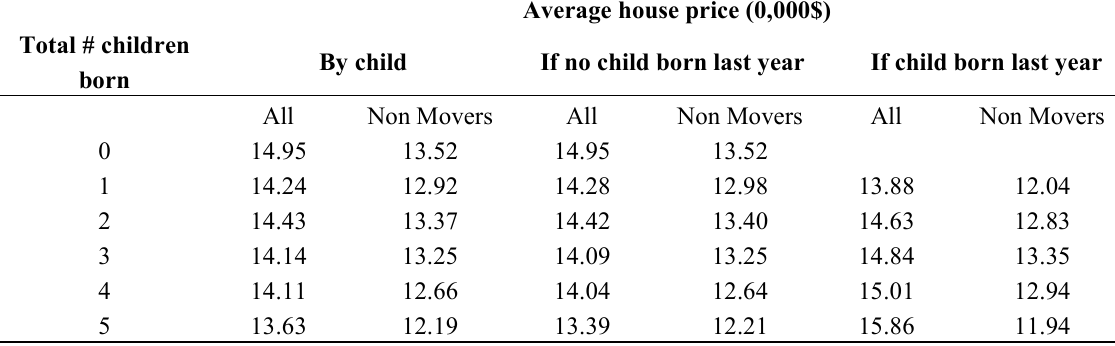
Appendix Table 2: Average house price and fertility for homeowners (used for Figure